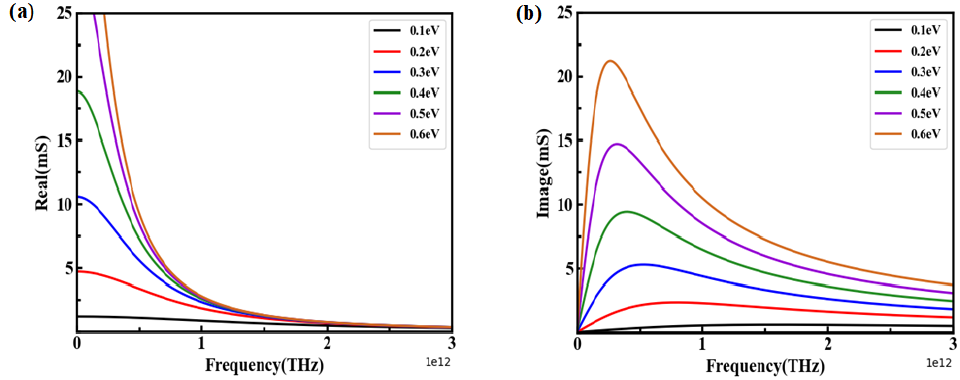
Figure 2. Conductivity with different 𝜇 𝑐 . ( a ) Real part; ( b ) imaginary part.